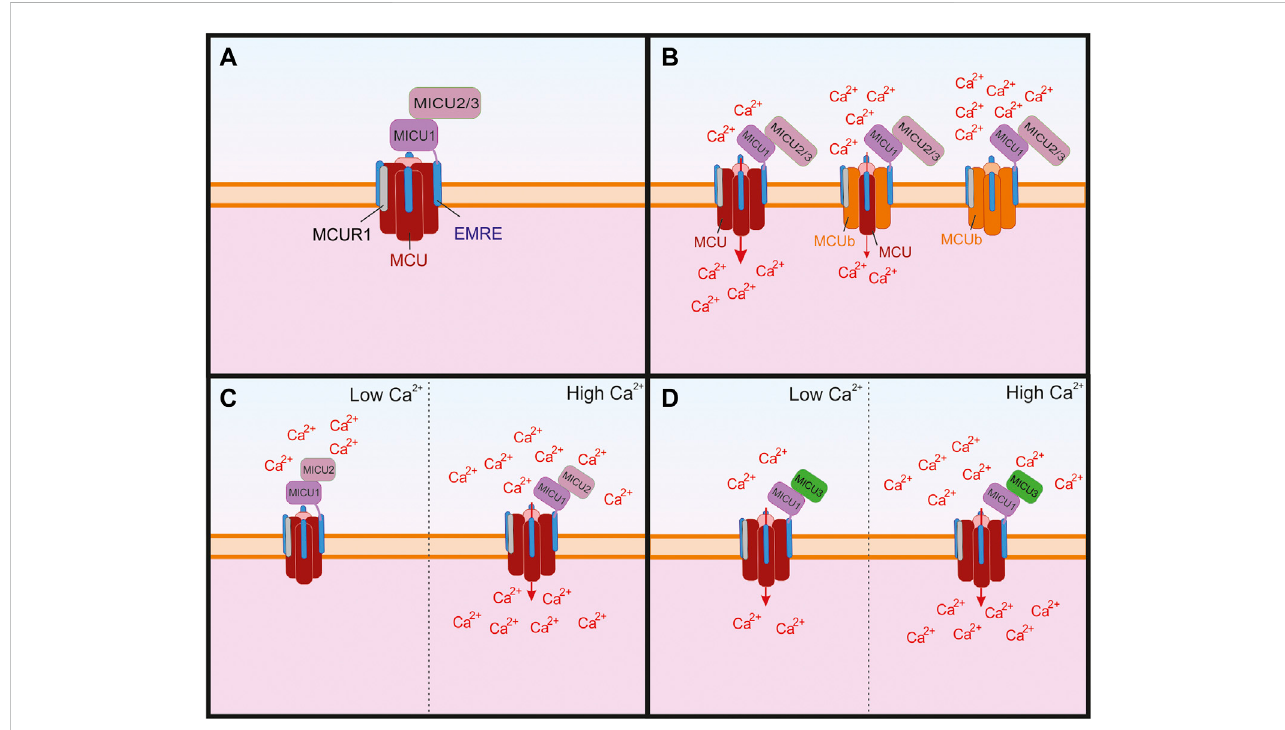
FIGURE 2 The structure of the greater mitochondrial Ca 2+ uniporter (MCU) complex and its subunits that can regulate its permeability. (A) The assembledcomplex containing a tetramer of pore forming MCU and four subunits of the essential MCU regulator (EMRE), which are critical for the proper assembly of the transmembraneMCUtothemitochondrialCa 2+ uptakeisoforms1,2,and3(MICU1 – 3).TheMCUcomplexalsocontainstheMCUregulator1(MCUR1),which isthought tobindto EMRE. (B) The MCU paralog MCUb hasbeen shown toreplace subunits ofporeforming MCU,which leads to reduced Ca 2+ through the channel and as more MCUb subunits replace MCU the Ca 2+ conductivity is reduced. (C) MICU1 and MICU two are critical for the Ca 2+ sensing function of the channel and MICU2 has been shown to regulate Ca 2+ sensitivity. When Ca 2+ is low, MICU1 blocks the pore, but in the presence of high Ca 2+ the conformational changes in MICU1 and MICU2 result in opening of the channel and allow Ca 2+ to enter the mitochondria. (D) In neurons, MICU3 is more abundantandhasbeenshowntoreplaceMICU2indimerswithMICU1.ThisreplacementleadstoincreeasedsensitivitytocytosolicCa 2+ oftheMCUcomplex and results in MCU channel opening to lower concentrations of Ca 2+ than compared to